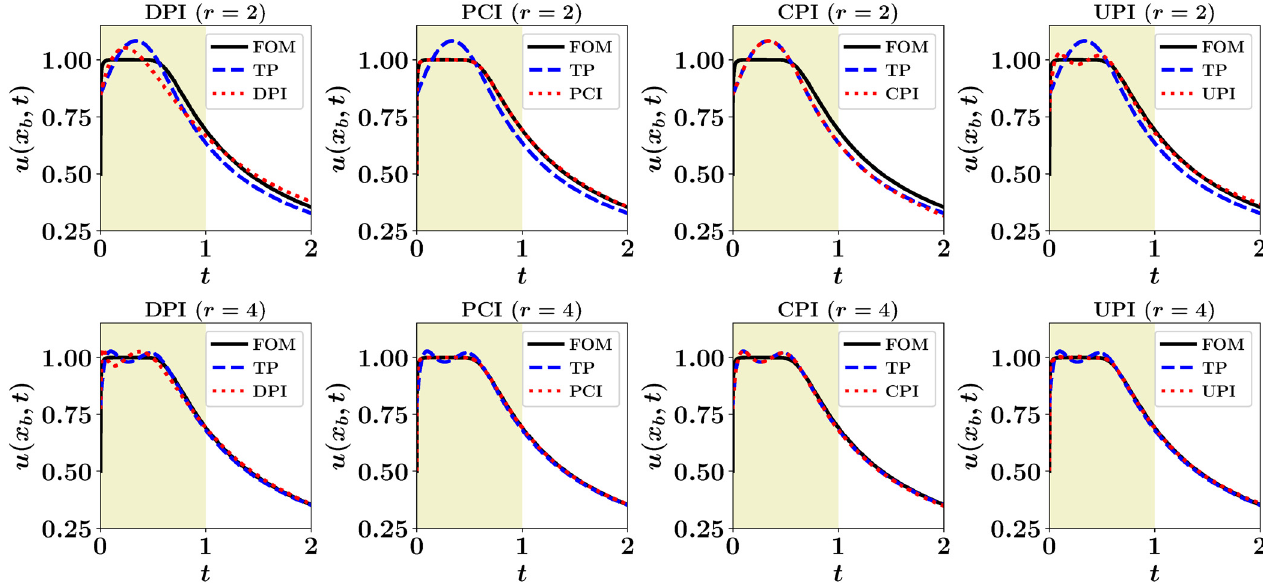
Fig 3. Velocity at the interface obtained by considering ROM in the left part of the domain, with r = 2 (top) and r = 4 (bottom). FOM solution corresponds to solving the governing equation over the entire domain, while TP denotes the projection of the FOM solution in the left zone onto the corresponding POD